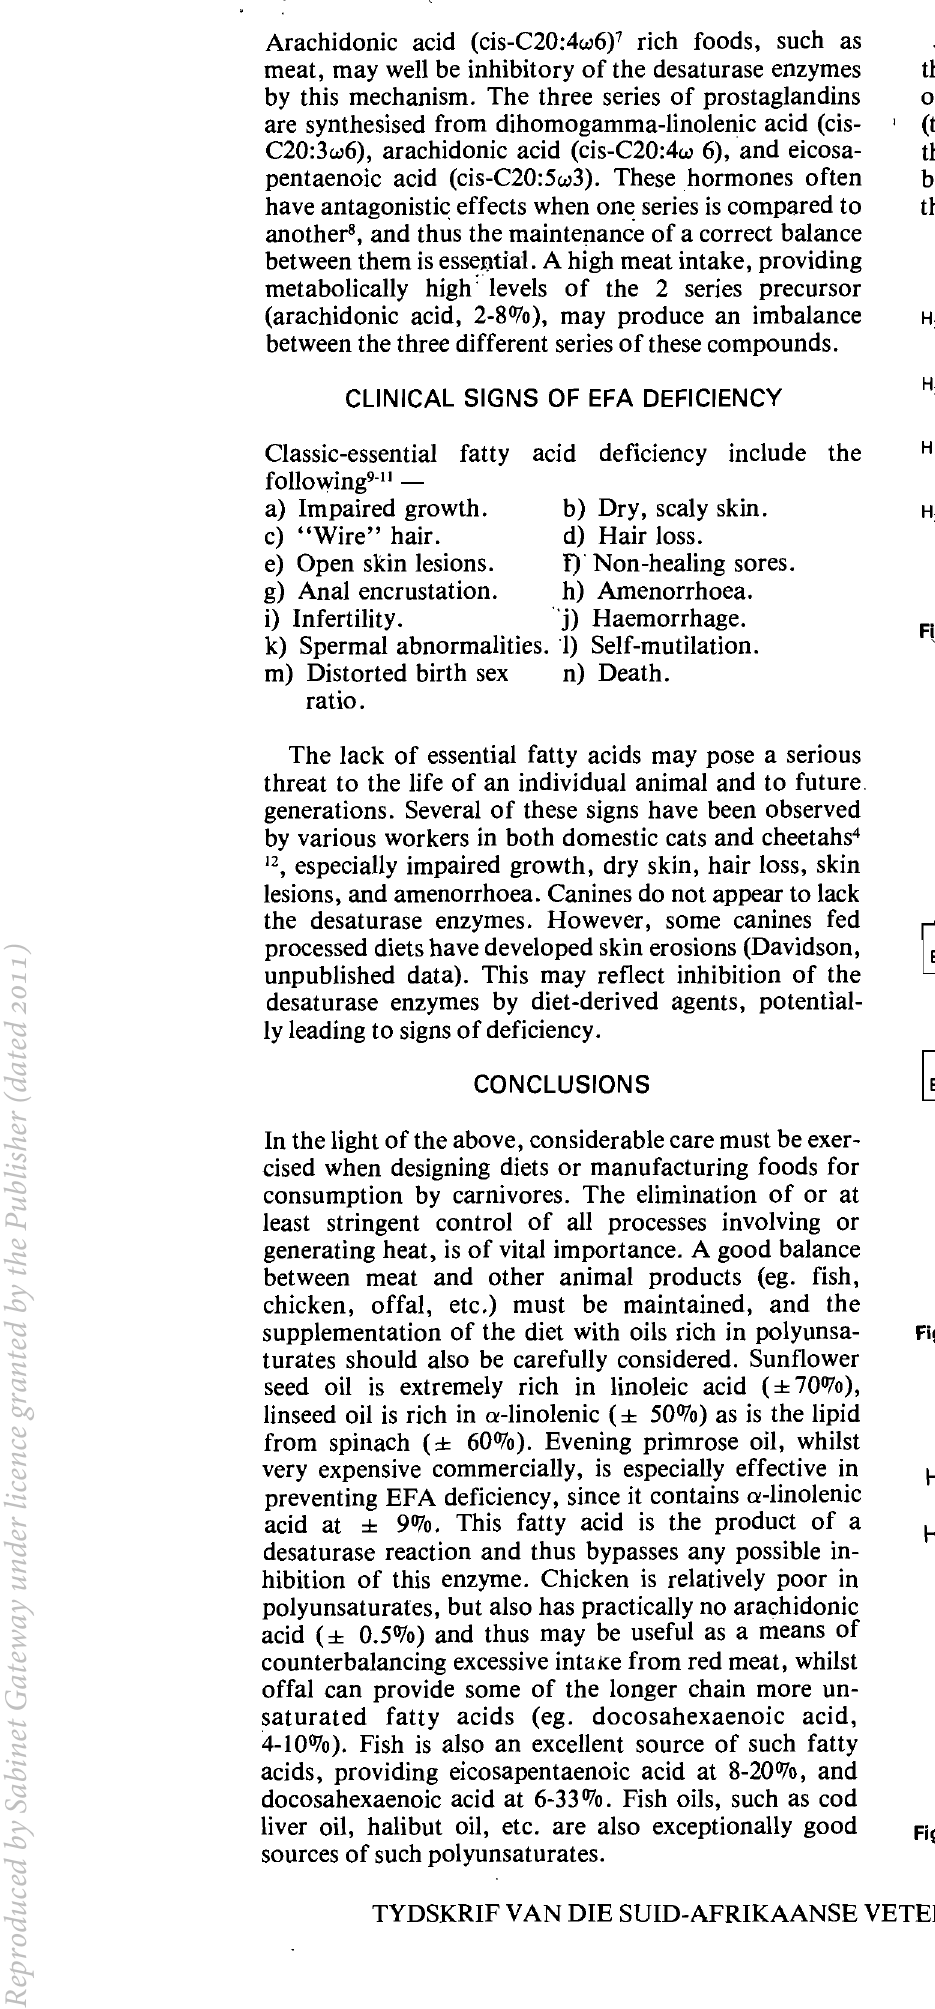
Fig. 3: The different isomeric configuration of fatty acid double bonds and the effects on the shape of the molecules. TYDSKRIF VAN DIE SUID-AFRIKAANSE VETERINERE VERENIGING - MAART